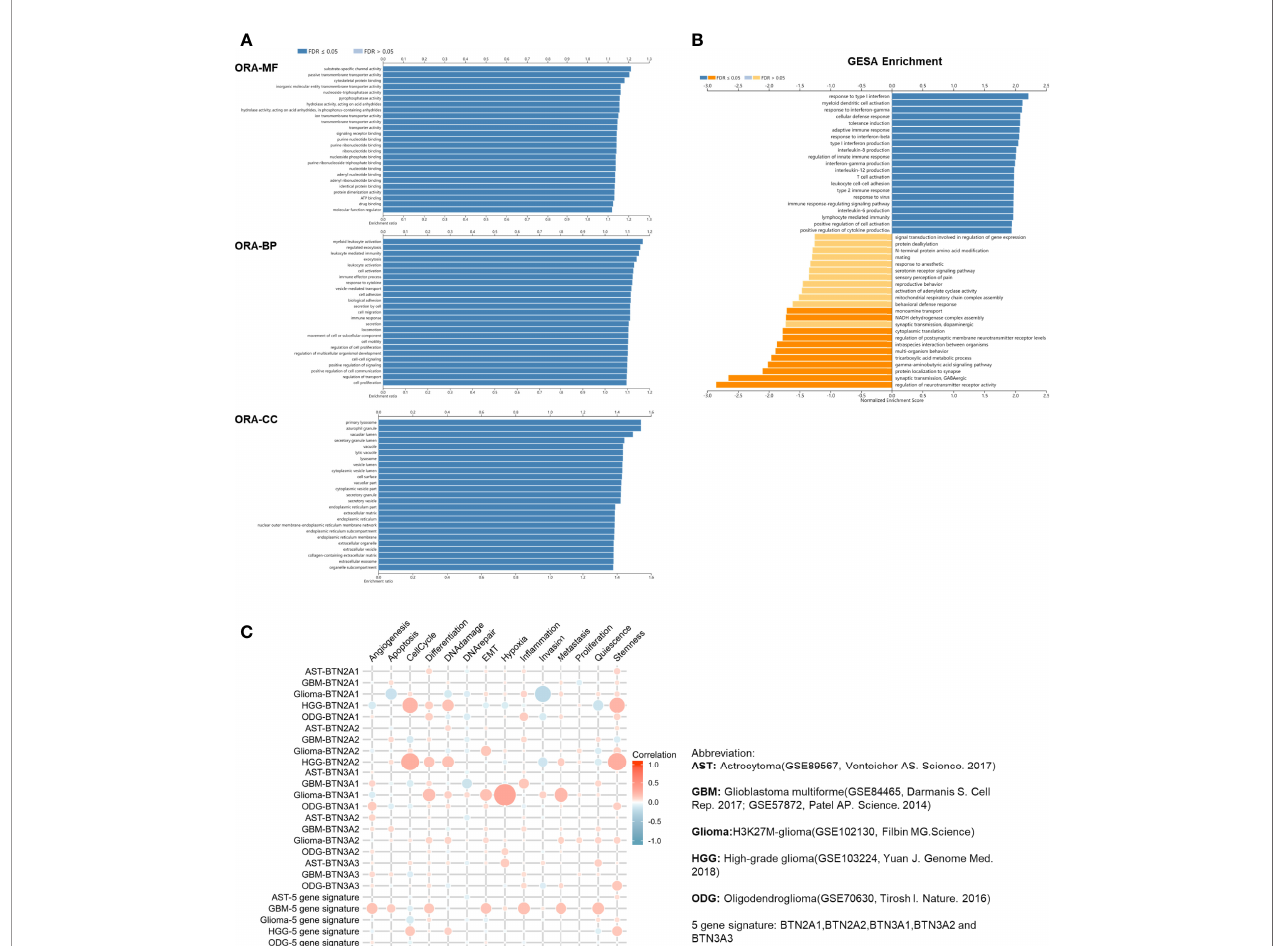
FIGURE 4 | Function of the BTN2/3 subfamilies in pan-glioma. (A) The ORA-based biological process (BP), molecular function (MF), and cellular component (CC) of BTN2/3 subfamilies were analyzed by LinkedOmics. (B) Gene set enrichment analysis (GSEA) of subfamilies was performed by LinkedOmics. (C) Single-cell analysis by CancerSEA indicated that BTN2/3 subfamilies were primarily involved in regulating the cell cycle, differentiation, and stemness. The abbreviations and references of the single-cell datasets are shown in the fi